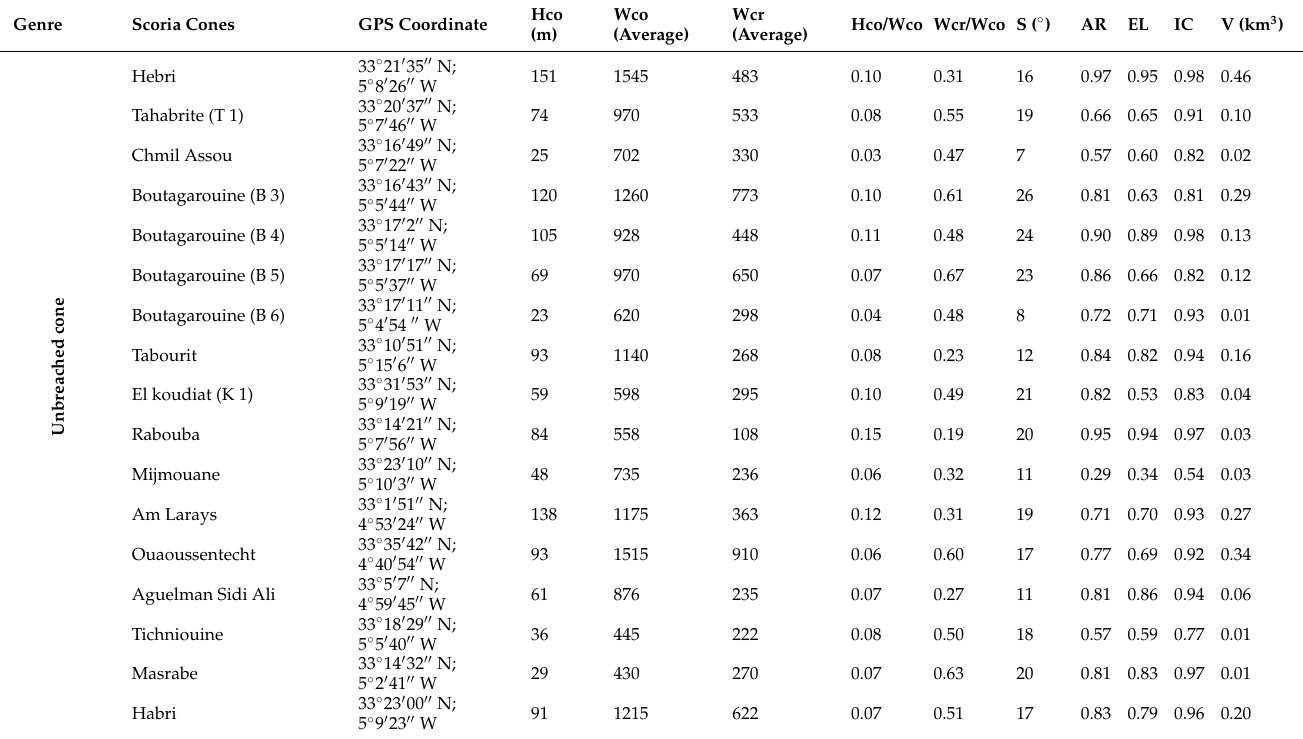
Table 1. The morphometric parameters of the scoria cones of MAVF (the GPS coordinates refer to the center point of the volcano). Asterix marks Unclassified